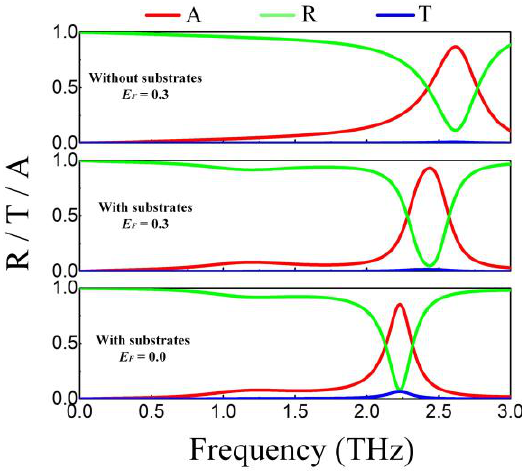
Figure 7. Absorption, reflection and transmission of the frequency-tunable absorber.